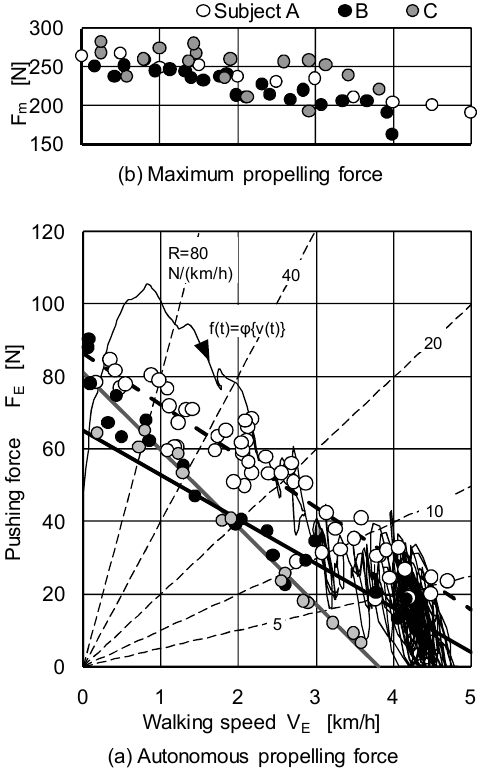
Fig. 4 Autonomous and maximum